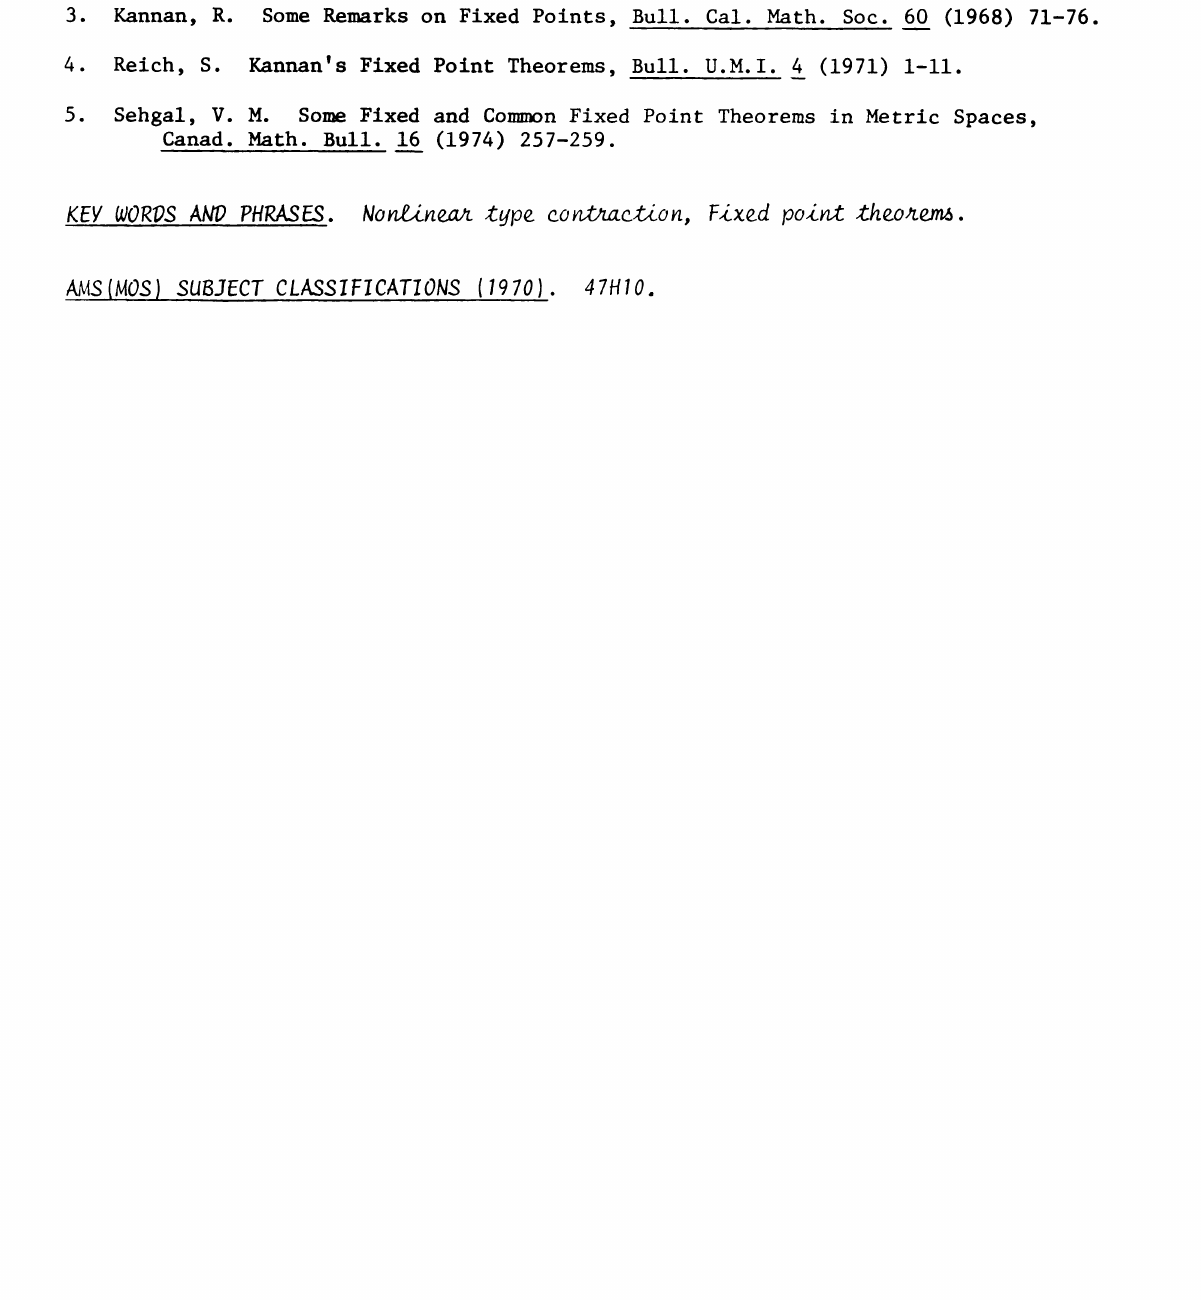
Nonlinea type coction, Fixed point